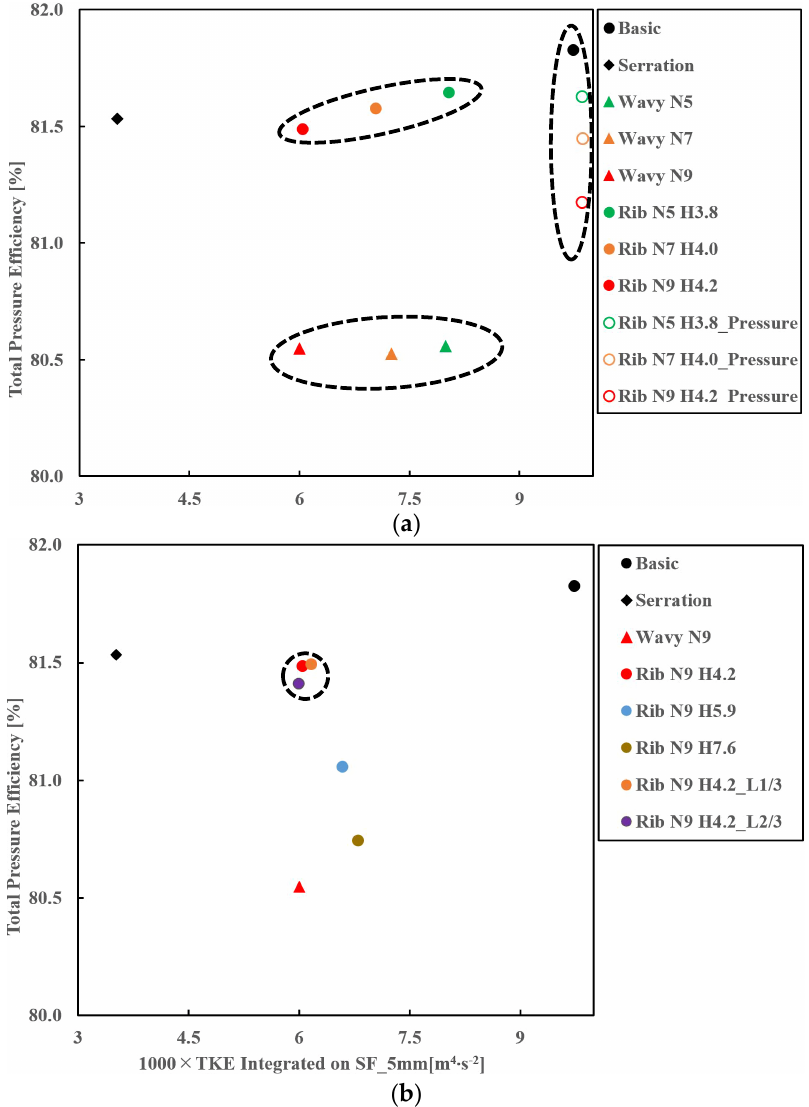
Figure 9. Total Pressure Efficiency versus 1000 × TKE of different blade designs. ( a ) Performance of different biomimetic design sets, ( b ) Exploration of groove parameters for the riblets on suction face designs. Note that the “Rib” set without “Pressure” represents riblets on suction face designs.